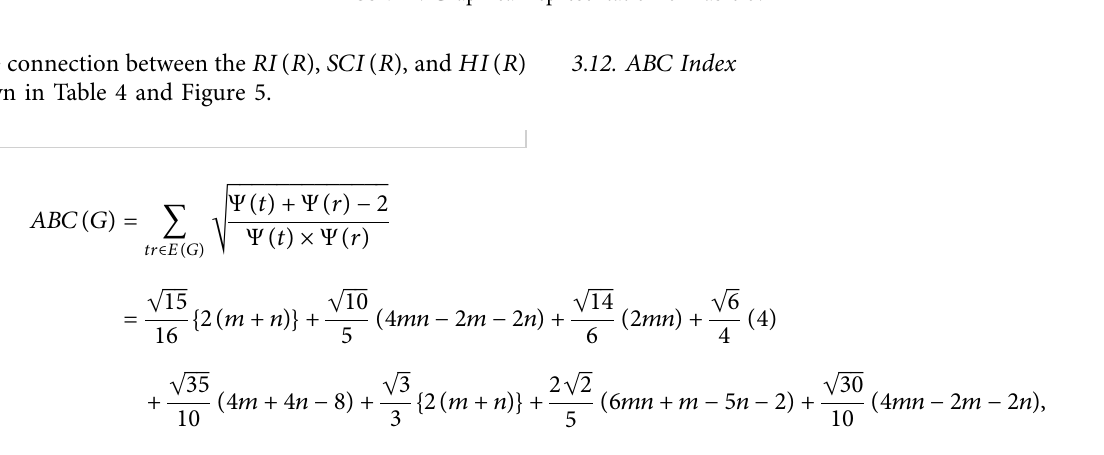
Figure 4: Graphical representation of Table